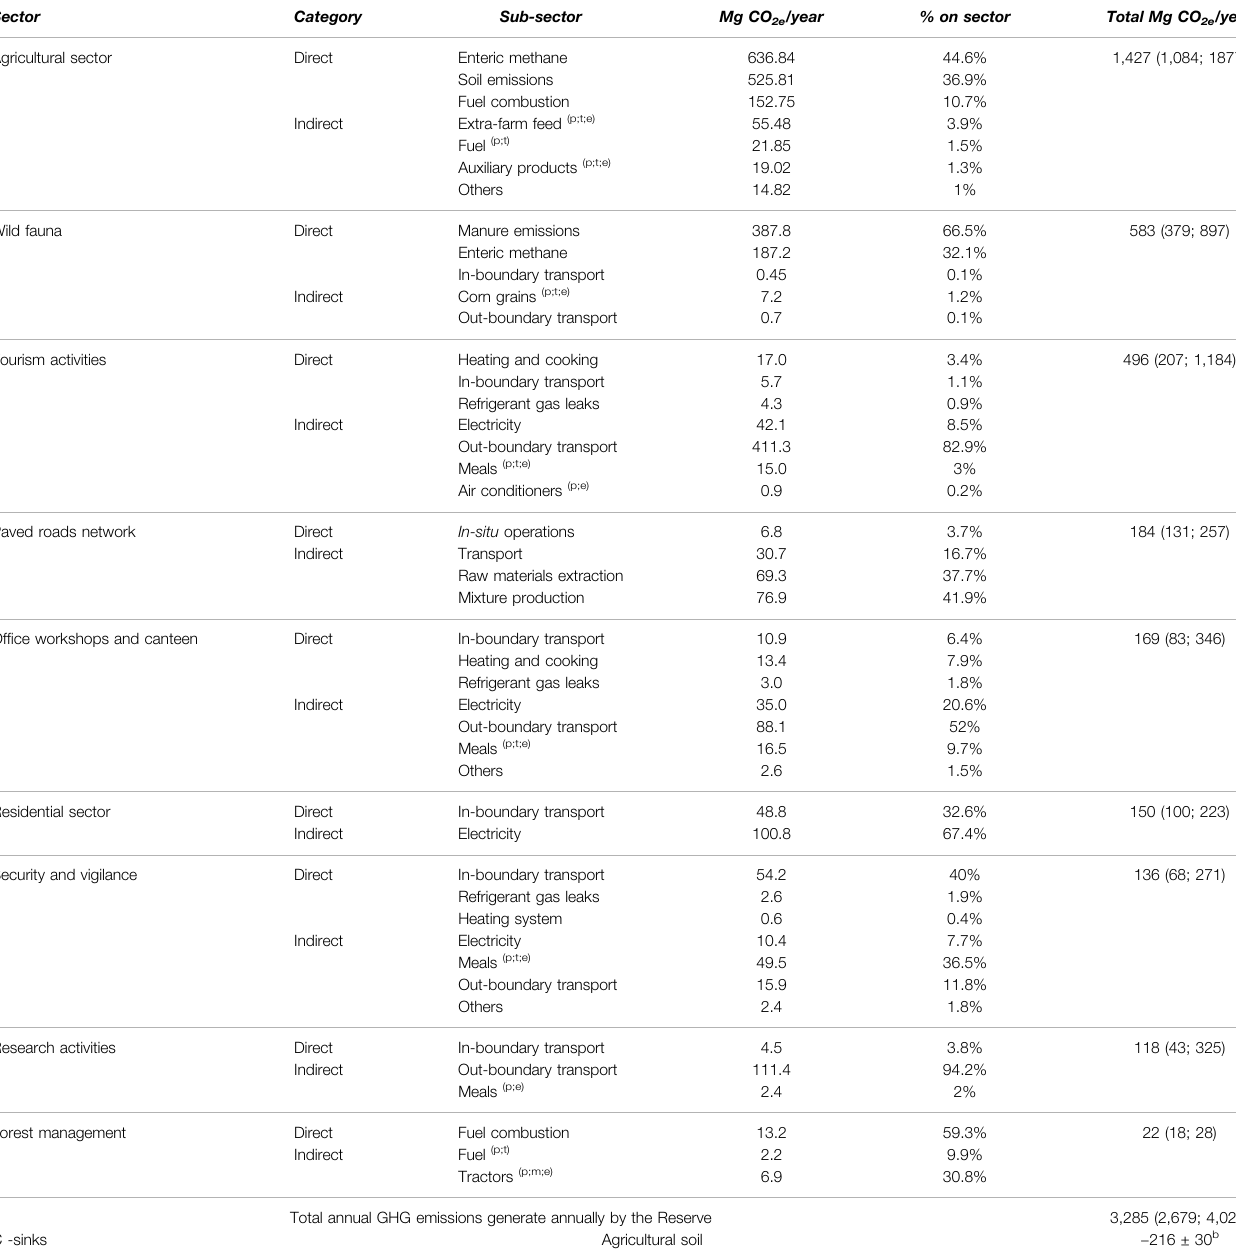
TABLE 1 | Overall GHG emissions and sink of the Reserve and incidence of the main emitting sources within each